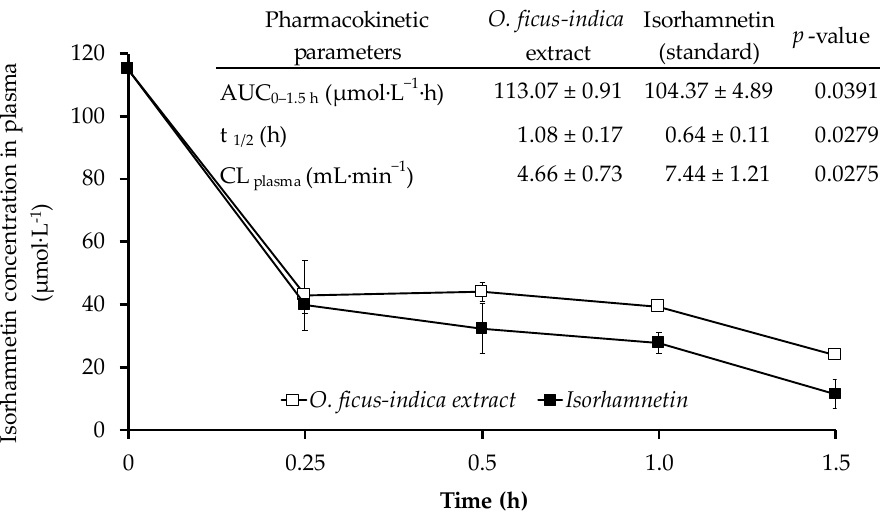
Figure 4. Isorhamnetin concentration ( µ mol · L − 1 ) in rat plasma and pharmacokinetic parameters after an intravenous dose (2 mg/kg) of an O. ficus-indica extract or isorhamnetin standard.